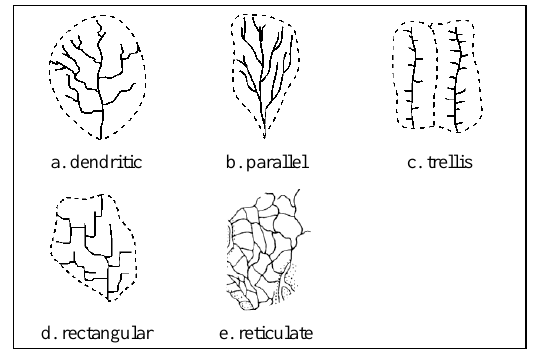
Figure 1. Drainage network patterns (diagrams modified from Ritter, 2006)